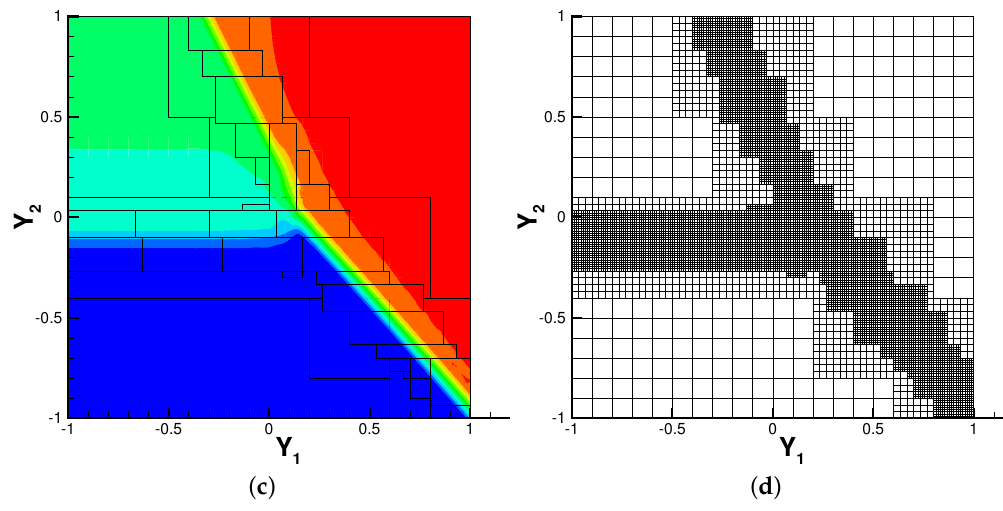
Figure 8. Contour plots of solution of the one-dimensional Burgers equation in random space. ( a ) numerical solution with (cid:101) = 1; ( b ) AMR mesh with (cid:101) = 1; ( c ) numerical solution with (cid:101) = 5; ( d ) AMR mesh with (cid:101) =